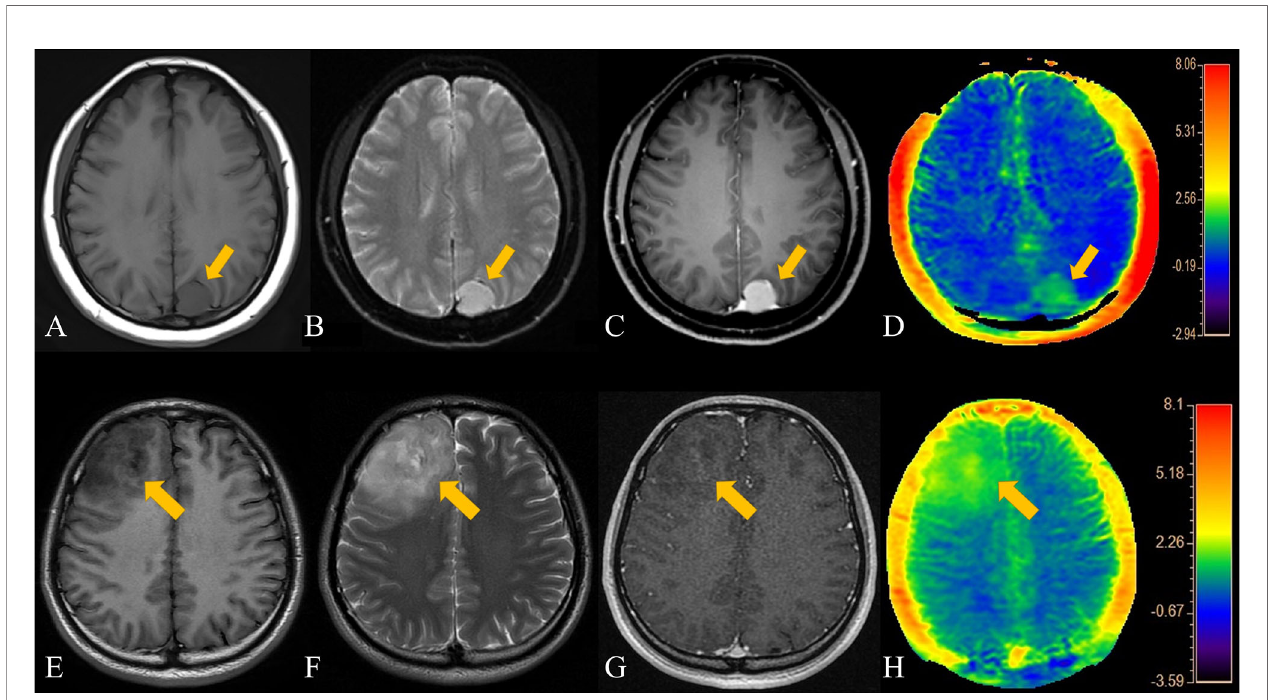
FIGURE 2 | Patient 1, a 44-year-old female, presented witha left parietallobemeningioma. The patient's T2WI, contrast-enhanced MRI, andAPT range were similar. (A) T1- weightedimaging showedan iso-slightlylow signal. (B) T2-weighted imaging showedaniso-slightlyhigh signal. (C) Enhanced MR imaging showed markedenhancement. (D) APT imaging shows a slightlyhigher rateofamide protontransfer. Patient2, a 34-year-oldmale, hadanLGG in the rightfrontallobe. The APT signal range of the patient was slightlylarger thanthat on both theT2WI andenhancedscans. (E) T1-weighted imaging showed aniso-slightlylow signal. (F) T2-weighted imaging showed aniso-slightly highsignal. (G) Enhanced MRI showedmild enhancement. (H) APT imaging showedthat the amide proton transfer rate slightly